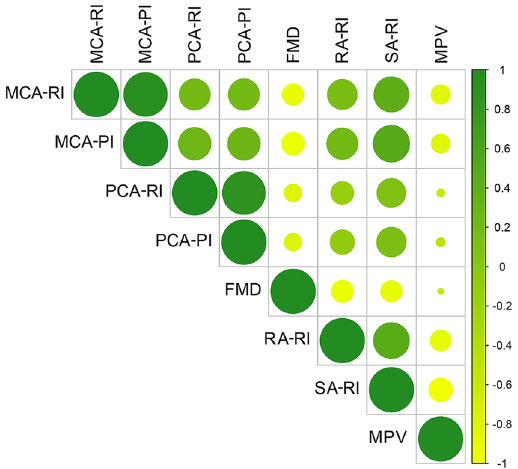
Figure 1. Correlations between systemic and splanchnic vascular resistance parameters and flow mediated dilation (FMD) in the study population. Positive correlations are represented in dark green, negative ones in light green. The size of the circle and color intensity are proportional to the correlation coefficient. RI = resistive index; PI = pulsatility index; MCA = middle cerebral artery; PCA = posterior cerebral artery; RA = renal artery; SA = splenic artery; MPV = mean portal vein velocity; FMD = flow mediated dilation.